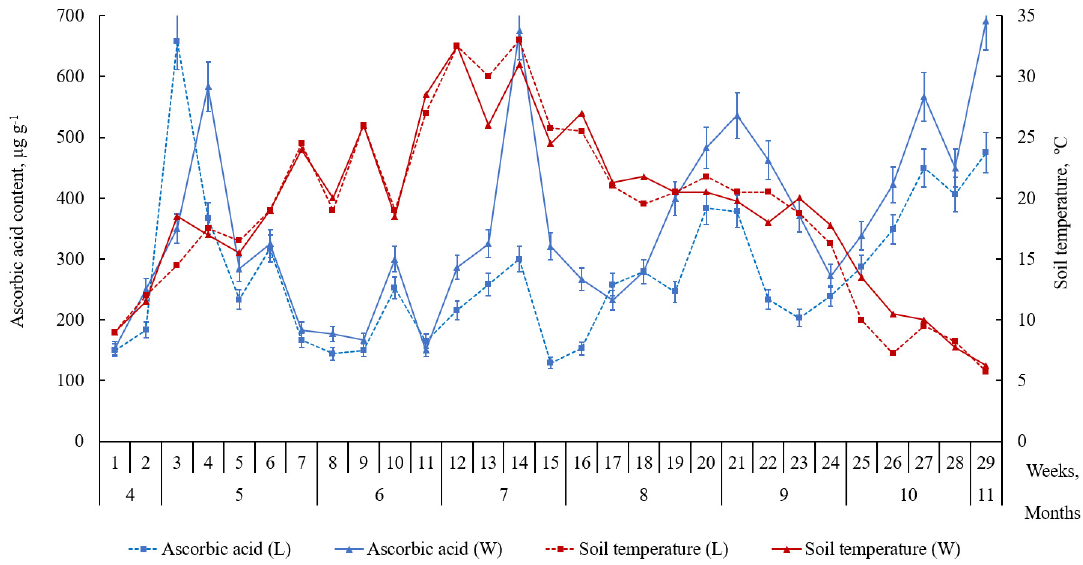
Figure 3. Content of ascorbic acid (AC) in the leaves of Lathyrus maritimus ( µ g g − 1 DW) and temperature conditions of the leeward (L) and windward (W) sides of the foredune (April–November 2018). Data are expressed as mean values ± standard deviations, (n = 45). Differences were considered significant at p ≤ 0.05. Phenological observations demonstrated (Figure 4) that the plants growing on the leeward side of the foredune enters the above-discussed stages one-two weeks earlier than their counterparts on the windward side do. Thus, the peaks of AC accumulation in the leaves of beach pea growing on the leeward and the windward sides of the foredune occurred at different times, but differences appeared only at the flowering.